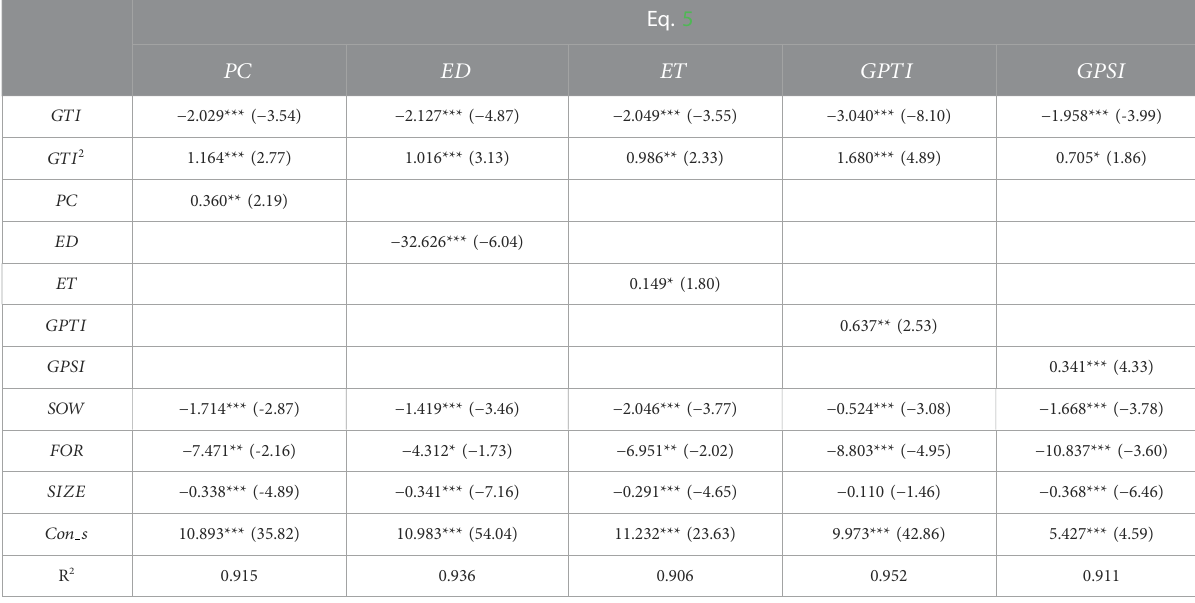
TABLE 9 Test results of impact paths